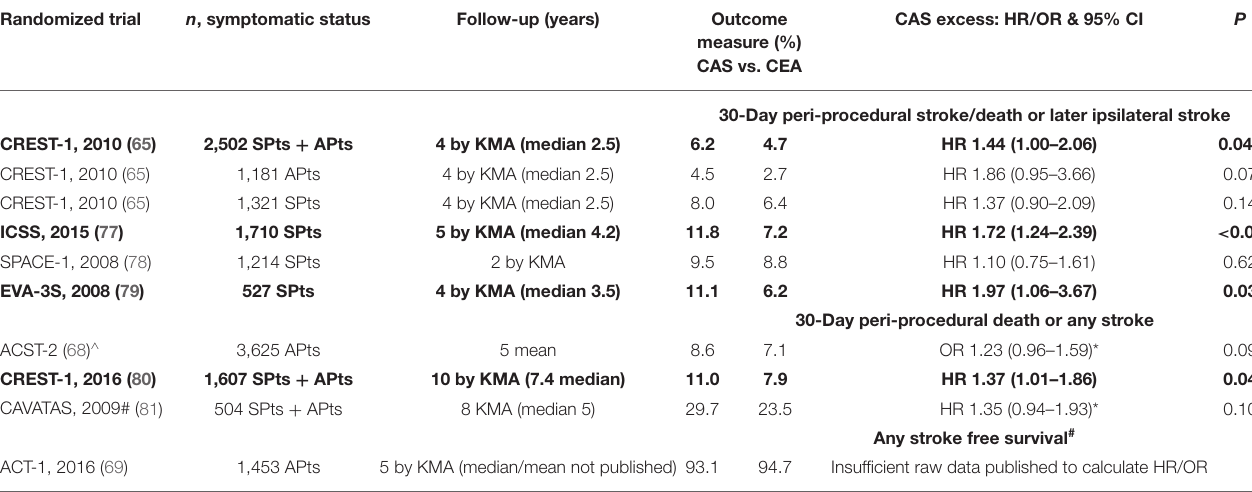
KMA, Kaplan Meier analysis; SPts, symptomatic patients with advanced ipsilateral carotid stenosis; APts, patients with advanced asymptomatic or recently (for at least 6 months) asymptomatic carotid stenosis. Bolded font indicates trials with sufficient statistical power to compare longer term stroke and death rate with CEA and CAS (including and beyond the peri-procedural period). #90% were symptomatic. * OR calculated from published raw data. ∧ Analysis using intention to treat